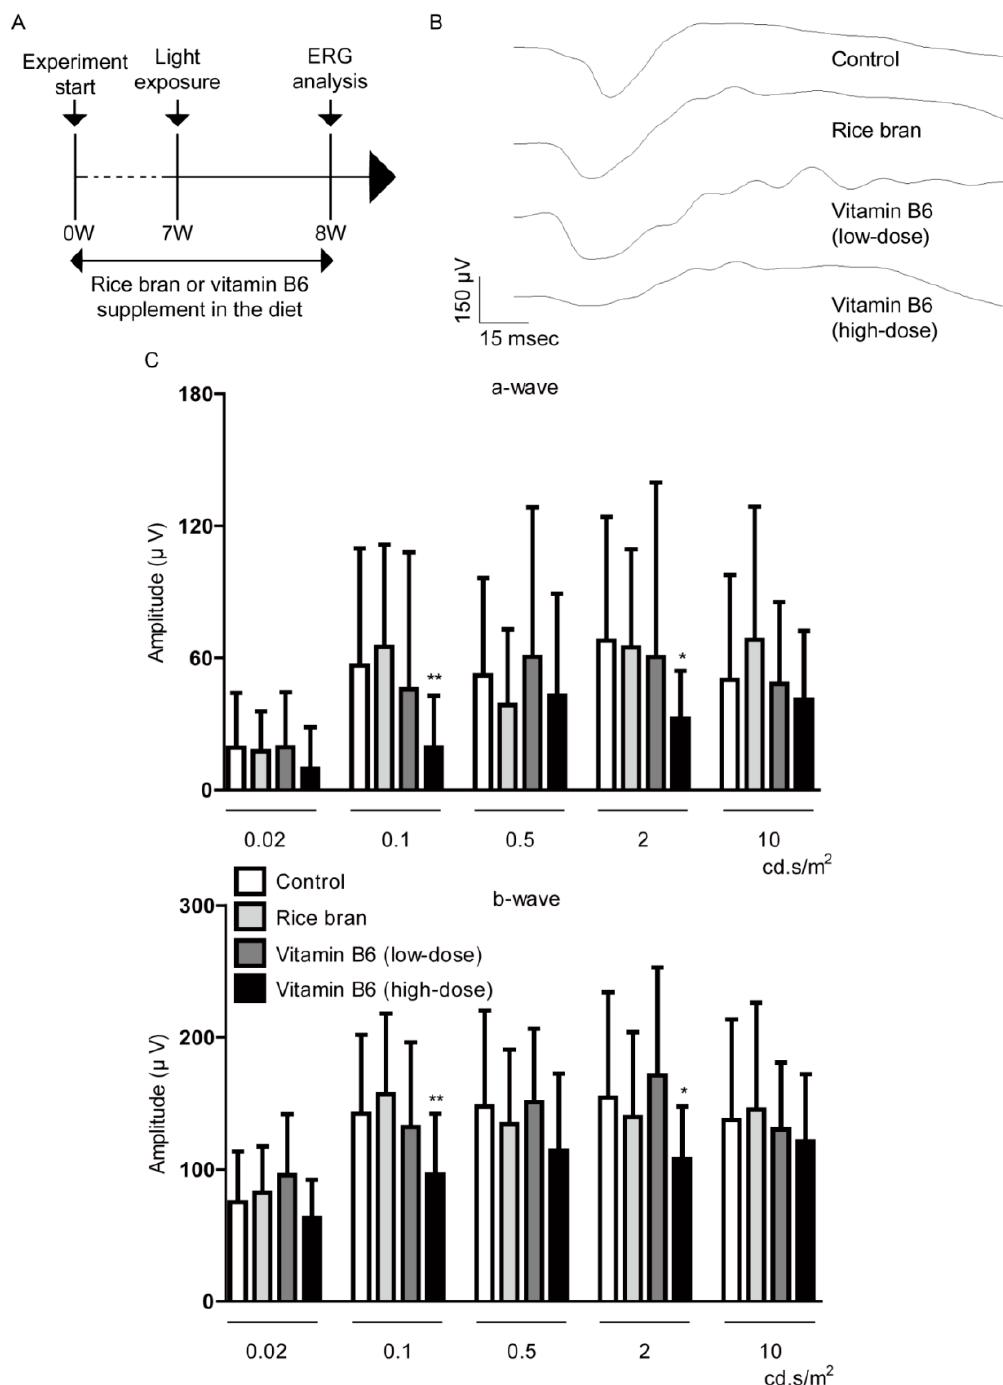
Figure 5. Direct retinal protection by rice bran and vitamin B6. ( A ) A schematic illustration demonstrates the murine light-induced retinopathy (LIR) model procedure and administration of rice bran or vitamin B6 to mice. ( B , C ) Representative waveforms of a- and b-waves (2 cd.s / m 2 ) and quantitative analyses showed that rice bran (587.5 mg / kg diet weight) or vitamin B6 (9 mg / kg diet weight) did not change the amplitudes of a-wave and b-wave in LIR mice ( n = 9–10 per group, 18–20 eyeballs per group). There was a significant decrease in the amplitudes of a-wave and b-wave in high-dose vitamin B6 (35 mg / kg diet weight)-administered LIR mice. * p < 0.05, ** p < 0.01, compared with control. The data were analyzed using Student’s t